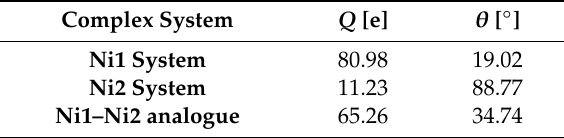
Table 9. Standardized values of effective net charge ( Q eff ) and open cone angle ( θ ) along with the values of catalytic activities of Ni1 complexes, Ni2 complexes and the analogue Ni1 – Ni2 system.